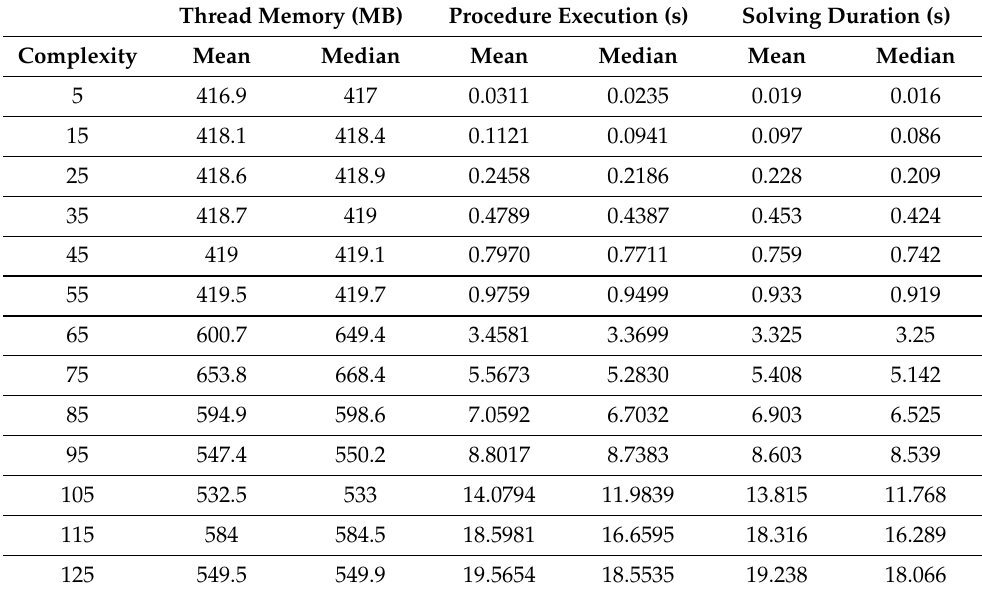
Table 3. Summary of basic statistic measurements per experiment (in